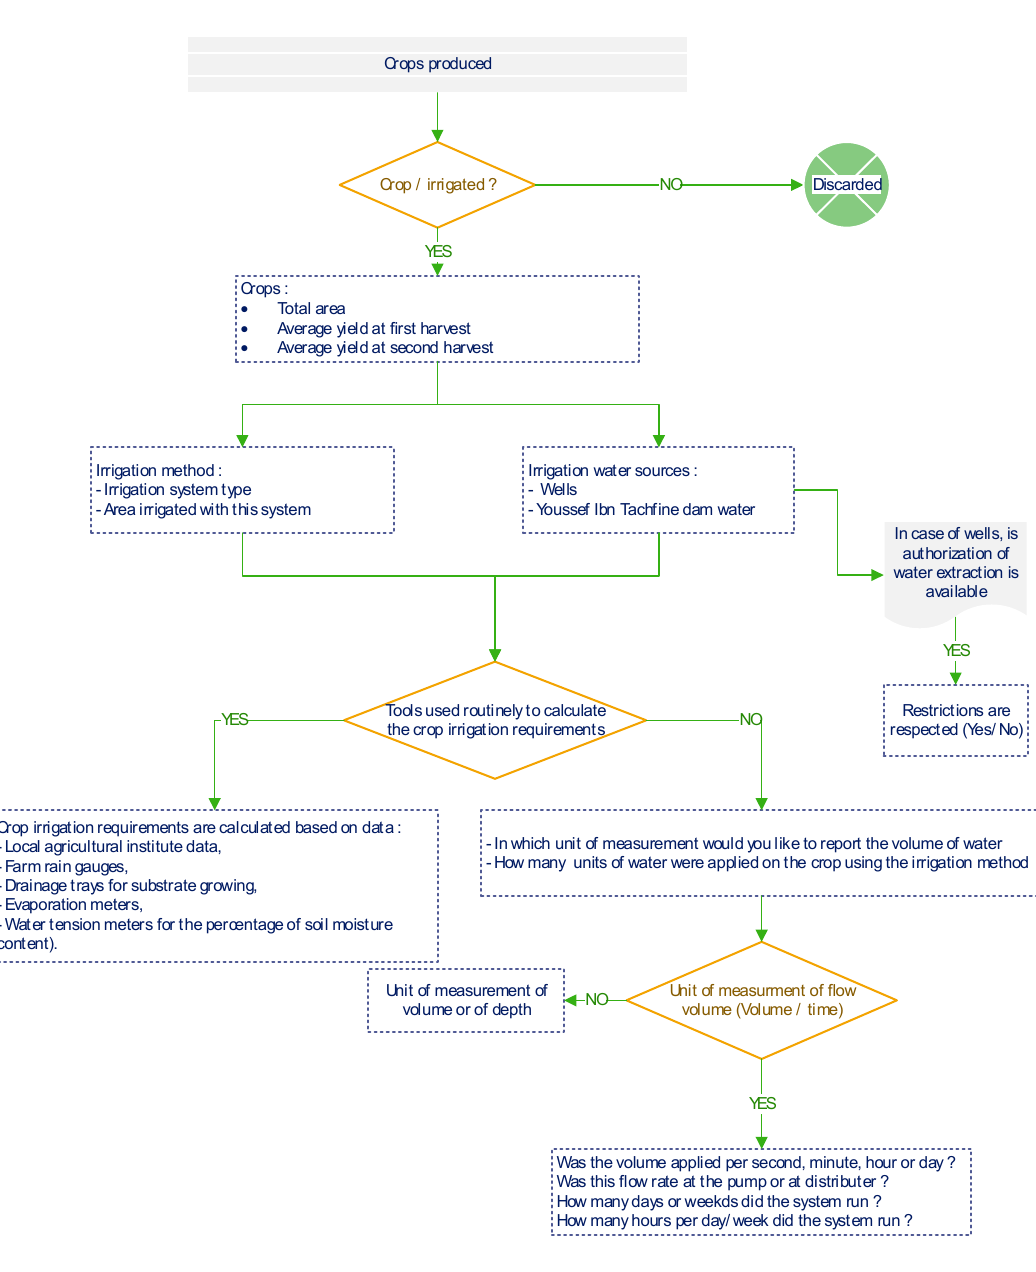
Figure A1. Field survey design used in our study.